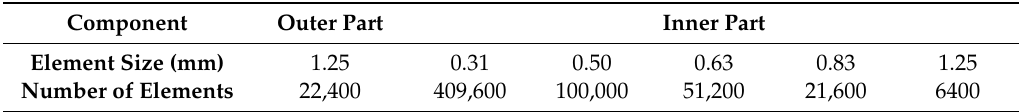
Table 5. The number of elements for 5 mm plate model.